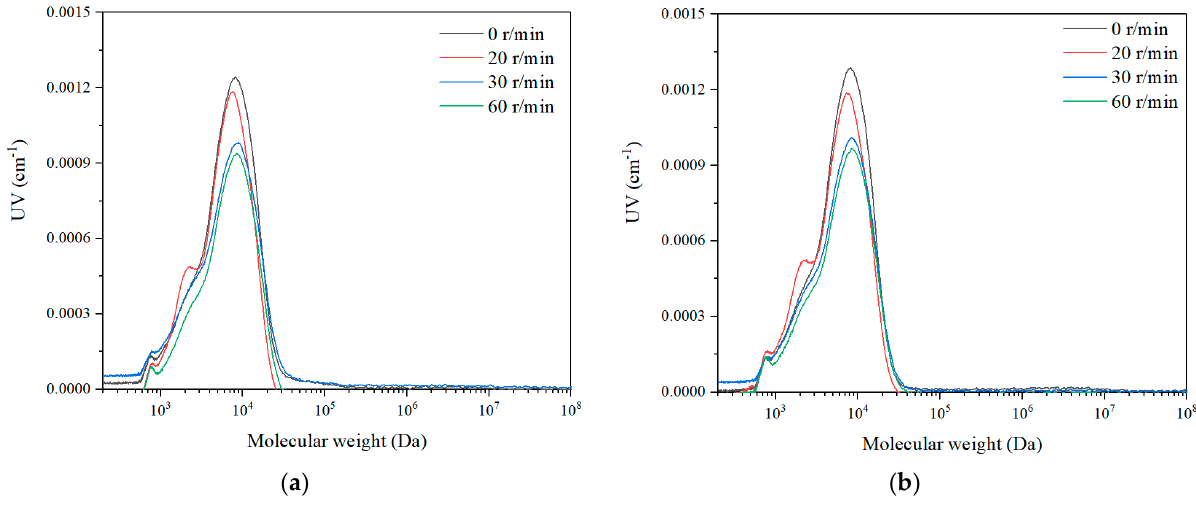
Figure 6. Molecular weight distribution (UV detection) with different rotation speeds in SA solution, ( a ) 1 h, and ( b ) 3 h.